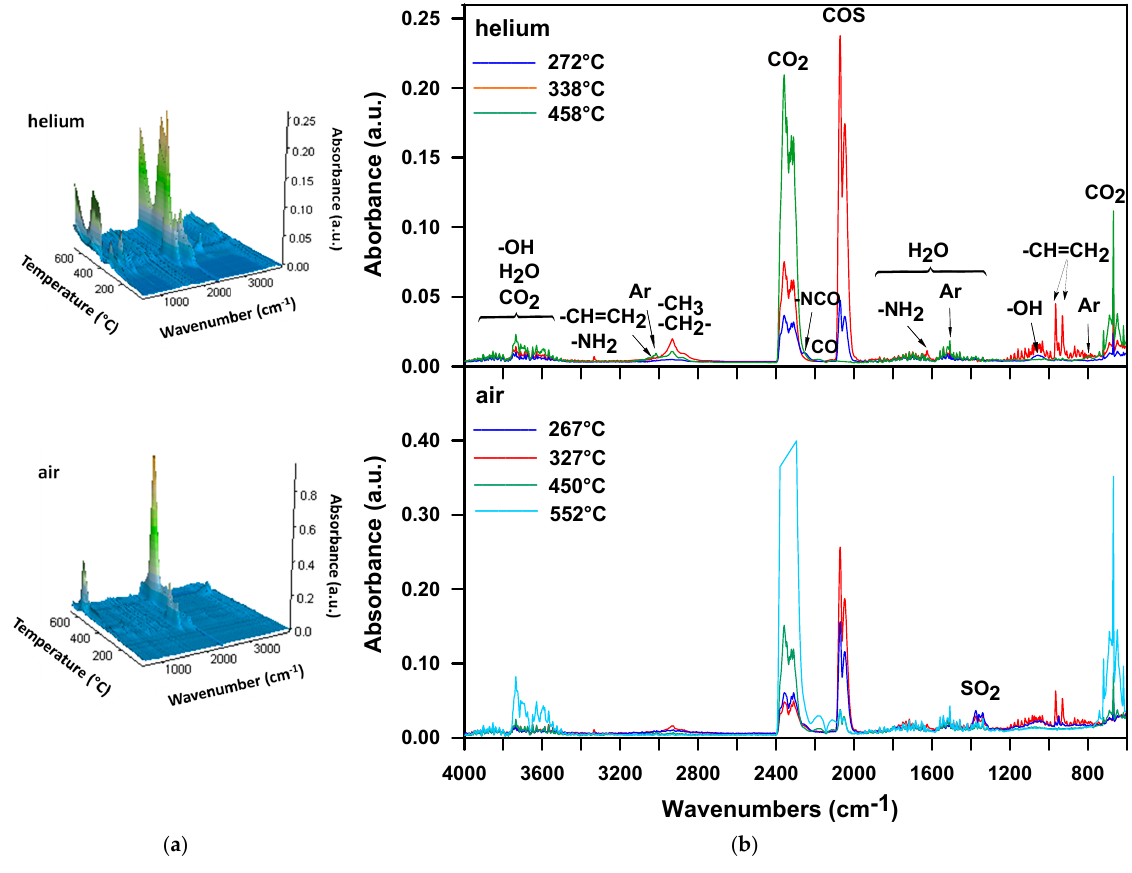
Figure 4. FTIR spectra of volatile products evolved during thermal decomposition of H-100: ( a ) 3D and ( b ) extracted at the maxima of decomposition.